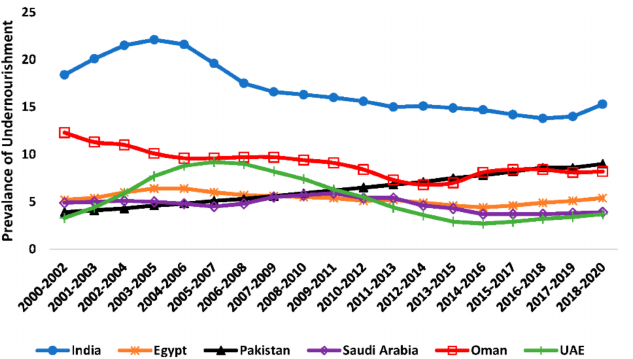
Figure 1. Prevalence of undernourishment in six countries (India, Pakistan, Egypt, Saudi Arabia, and the United Arab Emirates) [4].